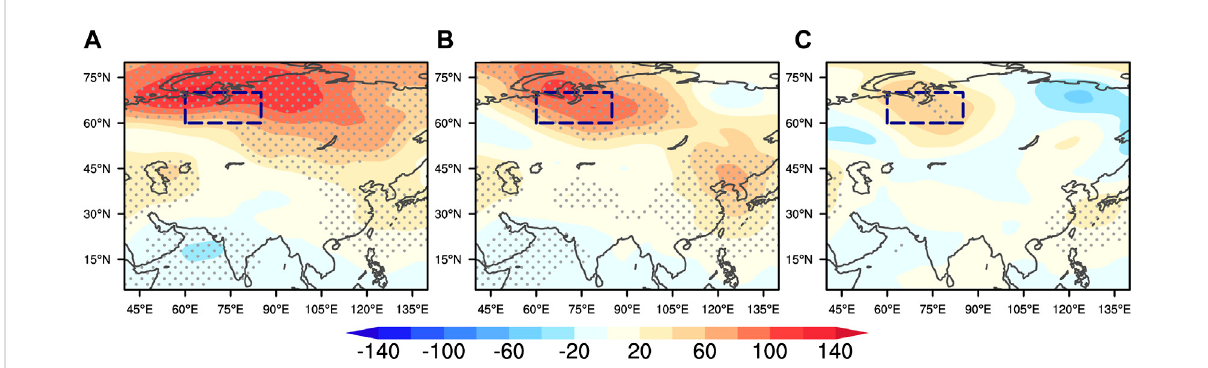
FIGURE 3 Differences of geopotential height between the onset day and the lead 15 d (A) , the lead 10 d (B) , the lead 5 d (C) (black box: the mid-high- latitude key region (60 ° N-70 ° N, 60 ° E-85 ° E); unit: gpm; dots are the areas with statistical signi fi cance exceeding the 95% level).